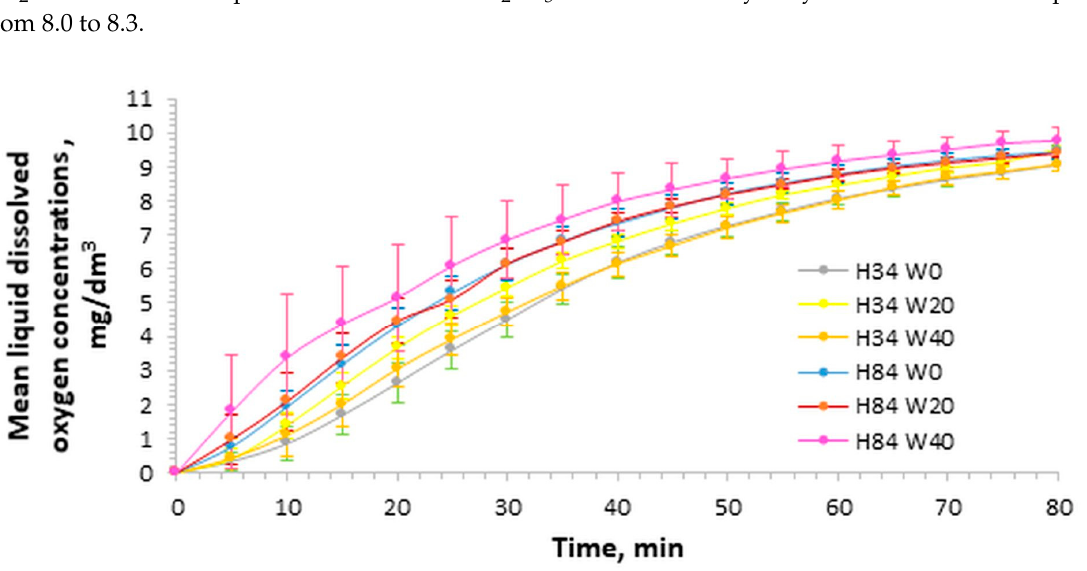
Figure 9. Mean liquid dissolved oxygen concentrations for the entire reactor volume for all structural design and filling variants.